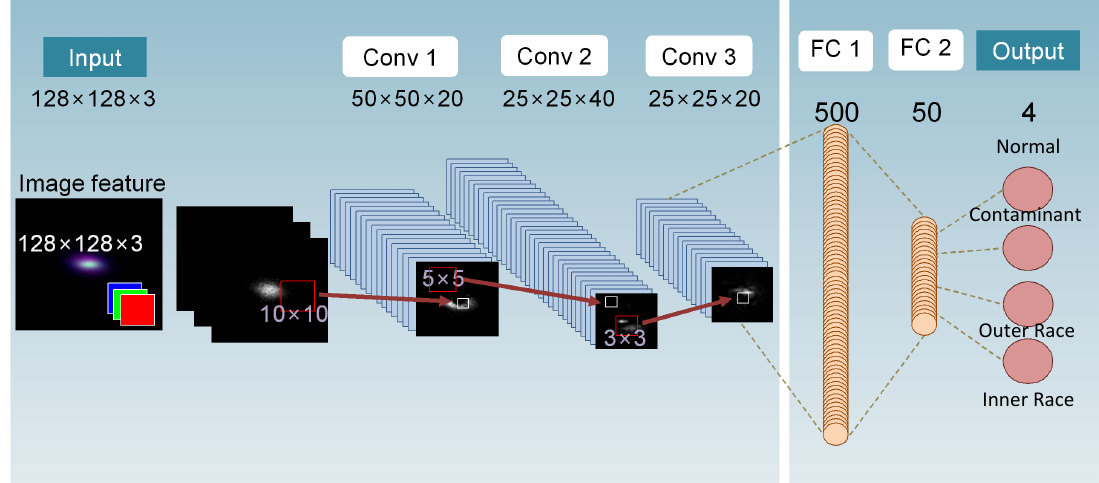
Figure 4. Convolutional neural network (CNN)-based bearing fault detector (CBFD)